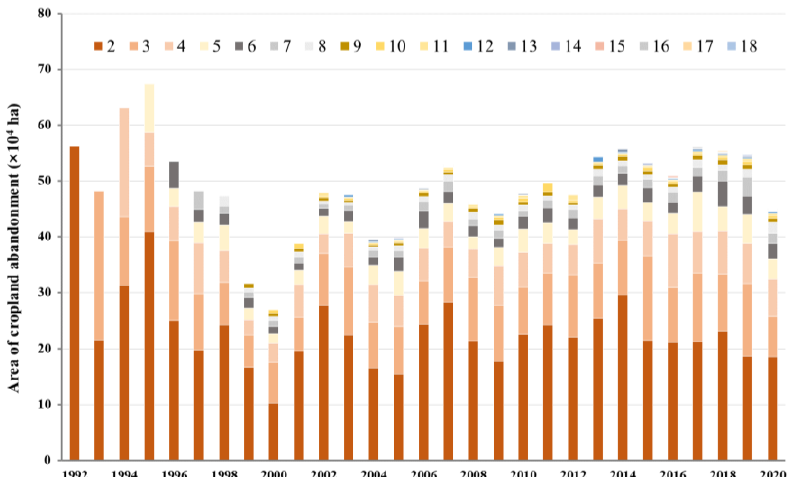
Figure 16. Area of different durations of cropland abandonment up to each year from 1992 to 2020.